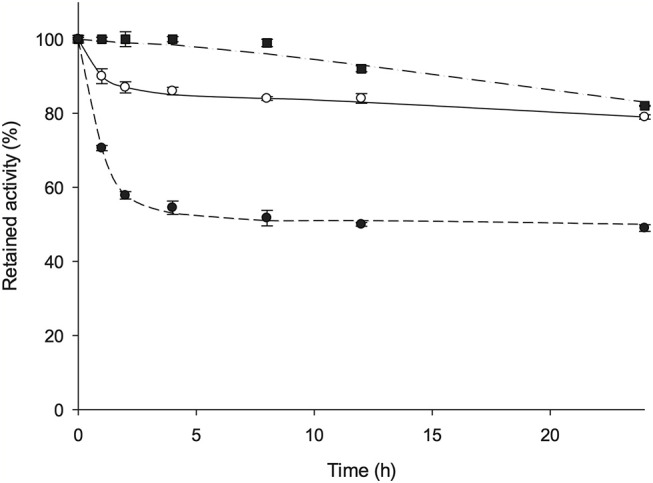
Time course of the thermal inactivation of AvNRT at (■) 60°C, (◦) 70°C, and (•) 80°C in 10 mM sodium phosphate pH 7.